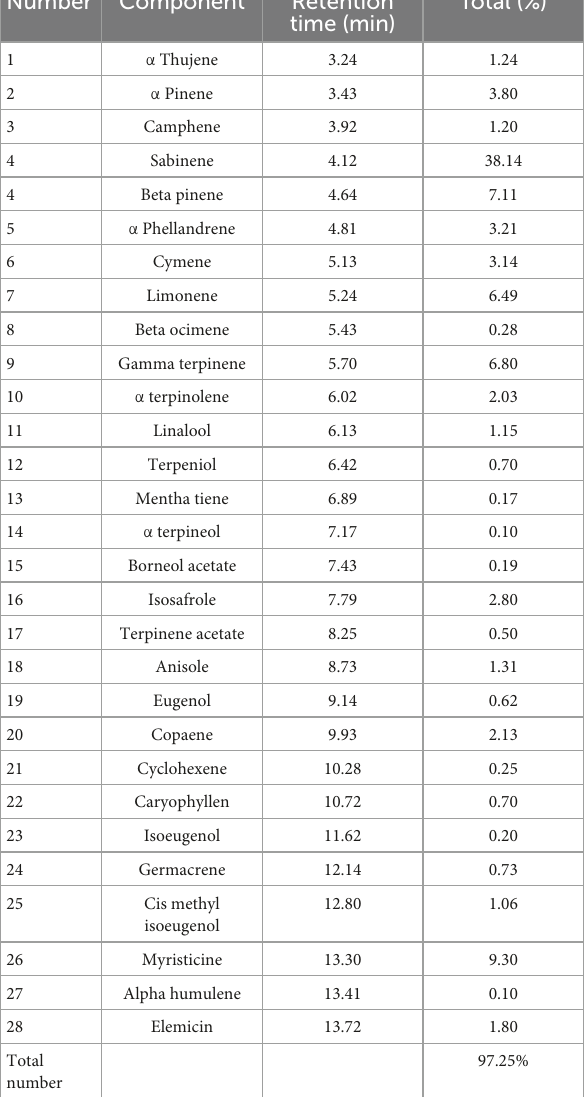
TABLE 2 Chemical composition of essential oil of Myristica fragrans using GC/MS